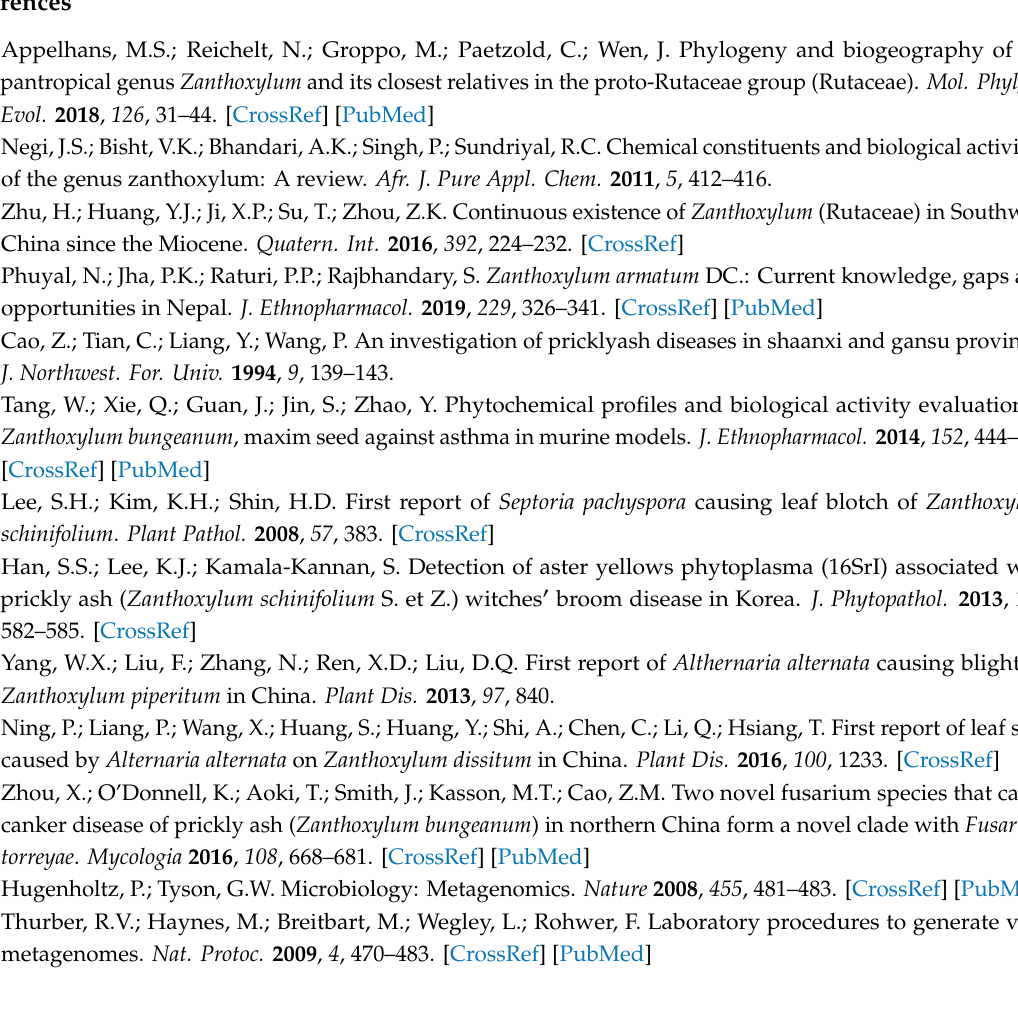
Figure S1: The size distribution of total small RNAs from symptomatic green Sichuan pepper sample. Table S1: List of primers used in this study. Table S2: The RT-PCR reaction systems and running programs of viruses detection. Table S3: Detection of the viruses in the asymptomatic green Sichuan pepper trees collected from Chongqing